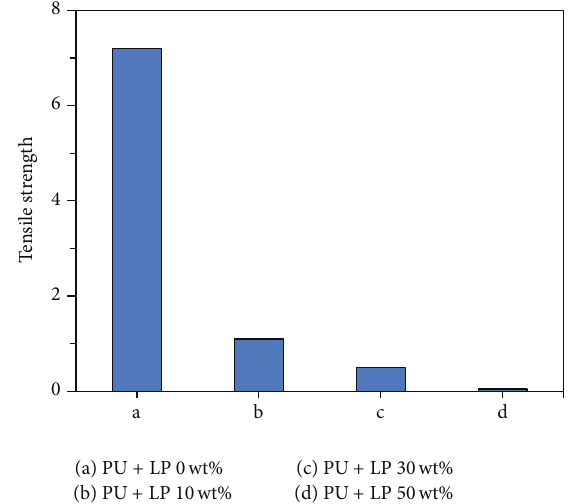
Figure 5: XRD patterns of different nanofibrous